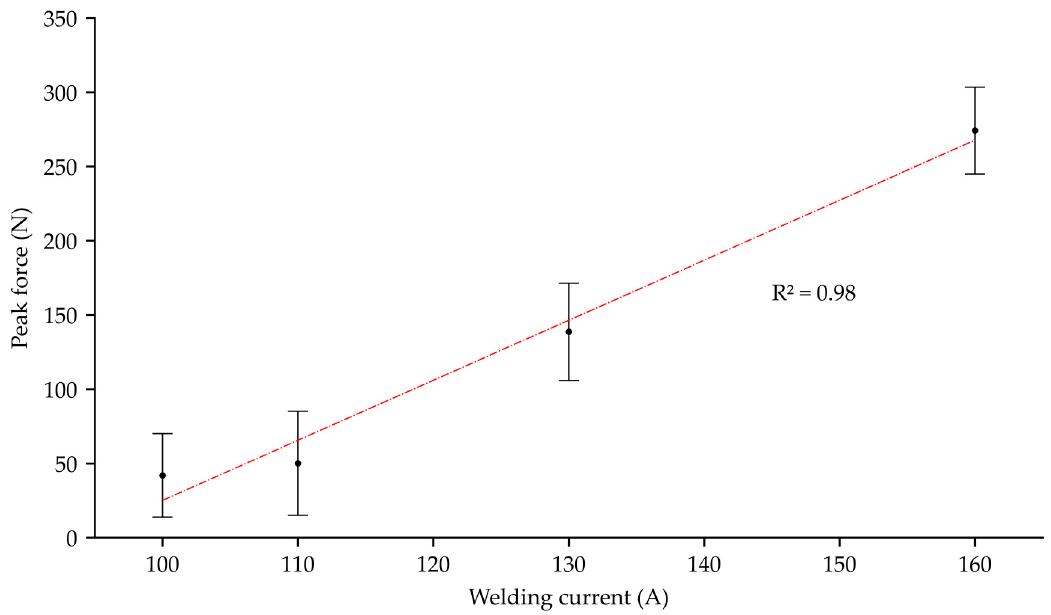
Figure 11. Lap-shear peak force with welding current. Points represent mean values of force and error bars represent one standard deviation from the mean.